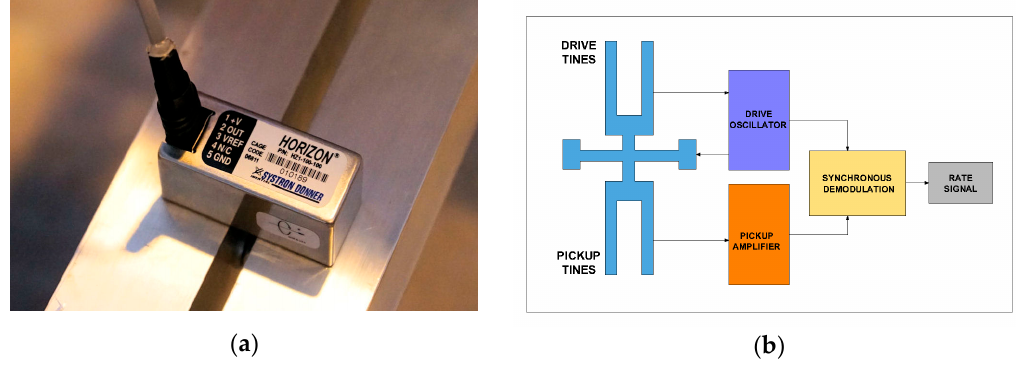
Figure 5. The Horizon™ MEMS angular rate sensor: ( a ) general view of the HZ1-100-100; ( b ) scheme of operation.